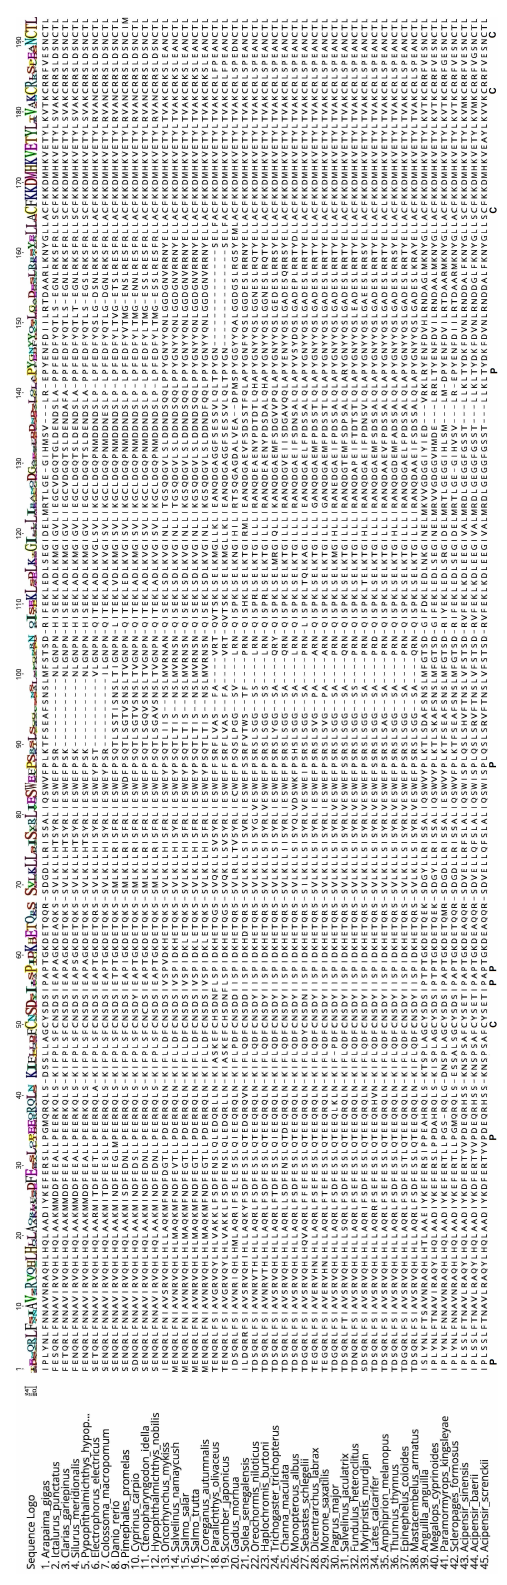
Figure 3. Alignment of the GH cDNA coding sequence from 45 fish species, including Arapaima gigas . The symbols indicate prolines (P) and cysteines